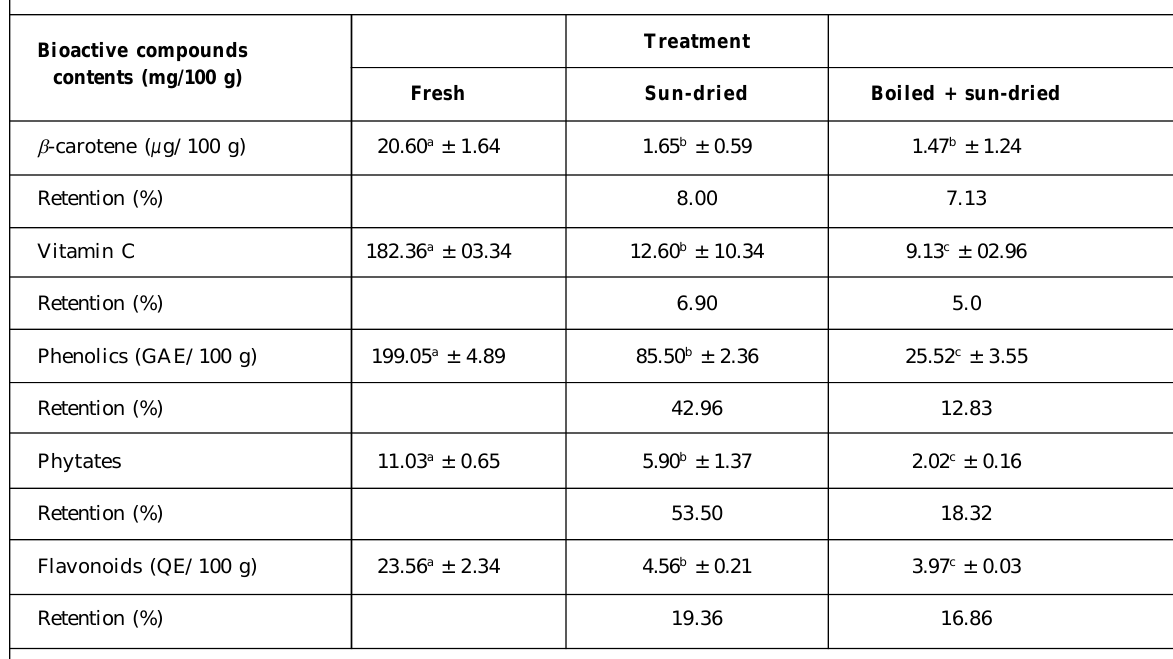
Table 3: Retention of bioactive compounds of fresh and traditionally processed cowpea leaves (dry basis) (mg/100 g) Bioactive